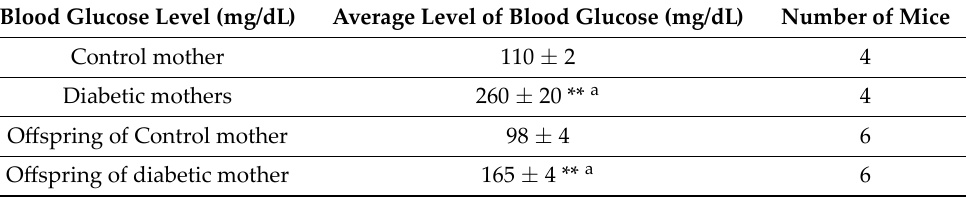
Table 3. Body Weight of Offspring of Diabetic Mother Versus